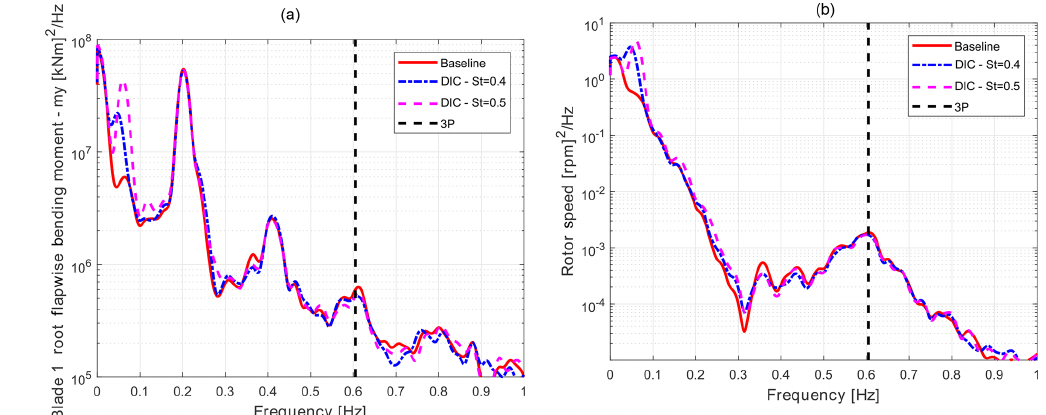
Figure 7. PSD comparison of the blade root flapwise bending moment (my) (a) and the rotor speed (b) between baseline (solid red) and DIC controlled with St = 0 . 4 (dash–dotted blue) and St = 0 . 5 (dashed magenta) turbine for NTM class A at 15ms − 1 .